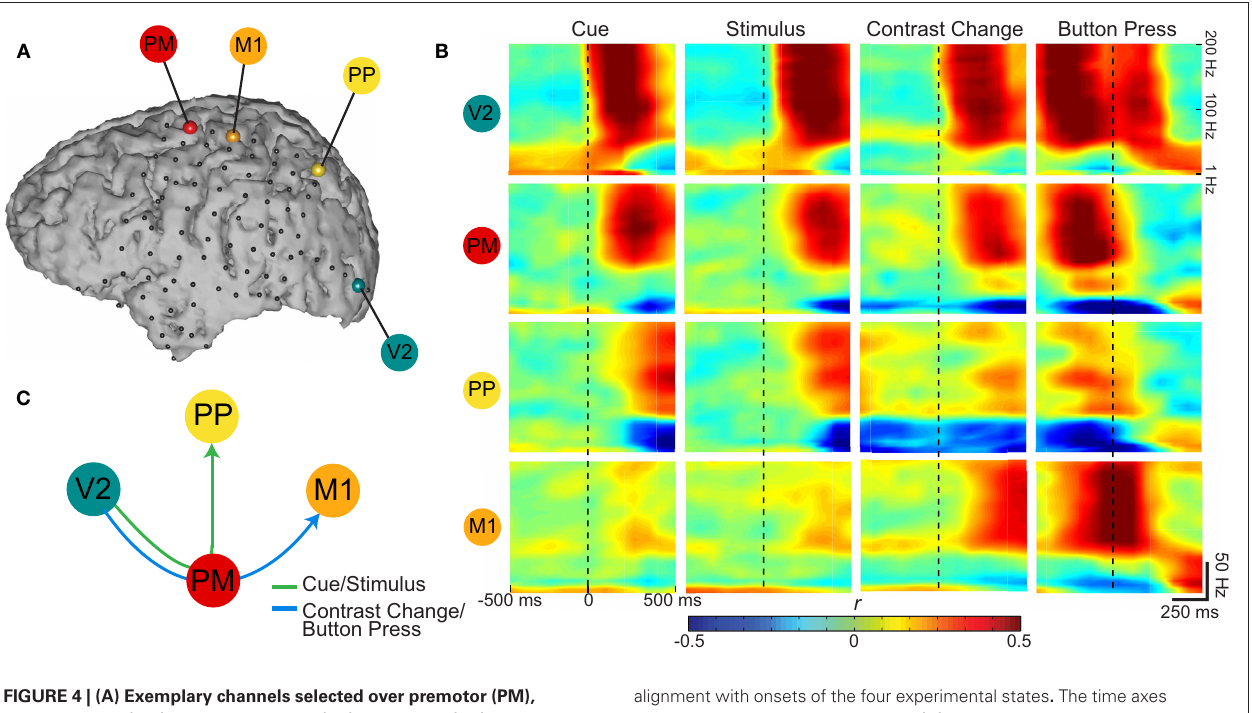
FIGure 4 | (A) exemplary channels selected over premotor (PM), primary motor (M1), posterior parietal (PP), and visual (V2) cortices in Subject A for time–frequency analysis. (B) Correlation coefficients (Pearson’s r ) between task states and spectral power as a function of time: Rows group the statistics in the color-coded electrodes across different experimental states (grouped in columns). Vertical dashed lines indicate